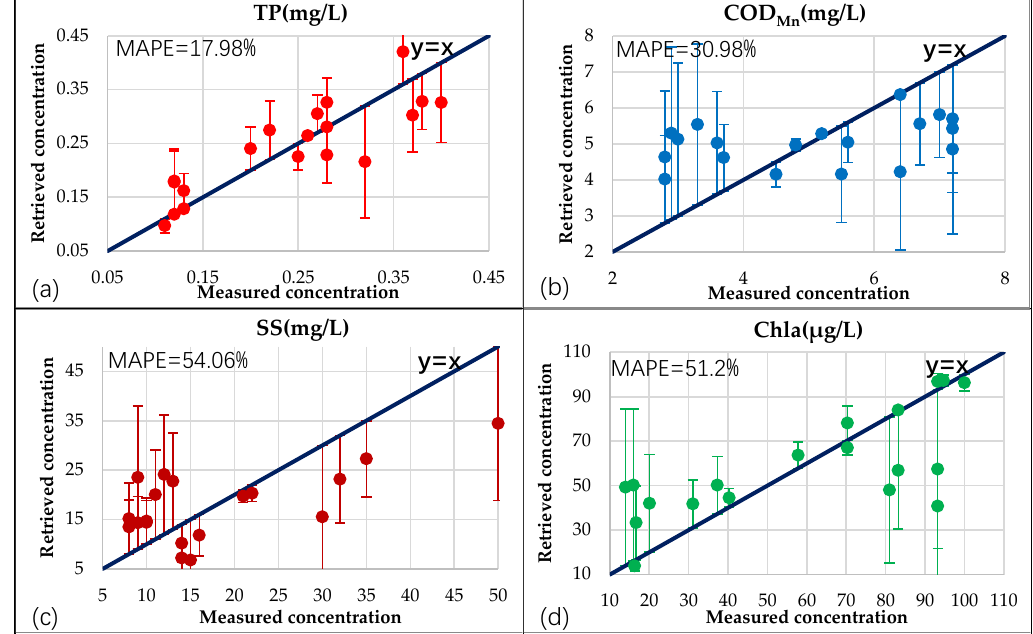
Figure 10. Measured and retrieved concentrations (using measured spectral data) and the mean absolute percentage error (MAPE) of water quality components at each sampling site: ( a ) TP, ( b ) COD Mn , ( c ) SS, ( d ) Chla.